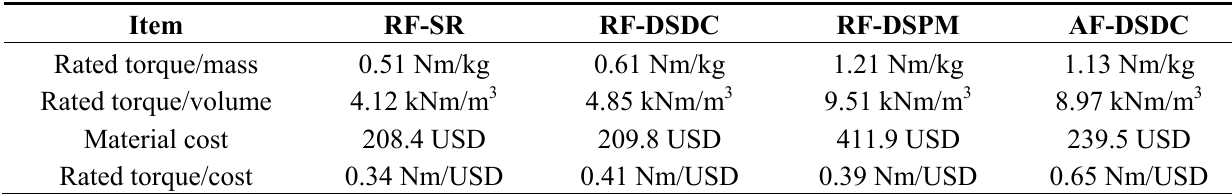
Table 5. Axial-flux (AF) and RF machine performance